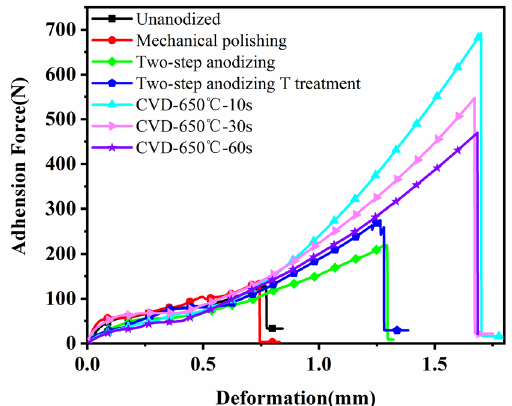
Figure 6: Test results for the adhesive force of metal - resin compo - sites treated with di ff erent methods.